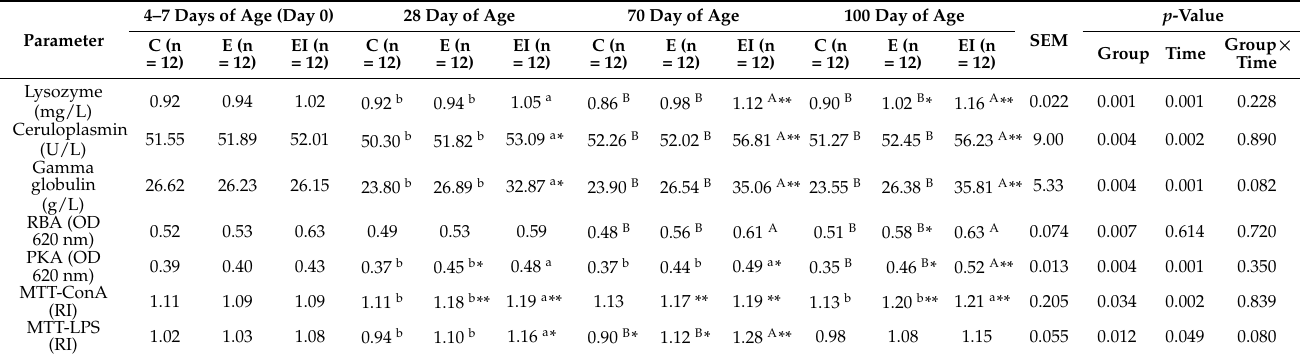
Table 5. Immunological parameters in